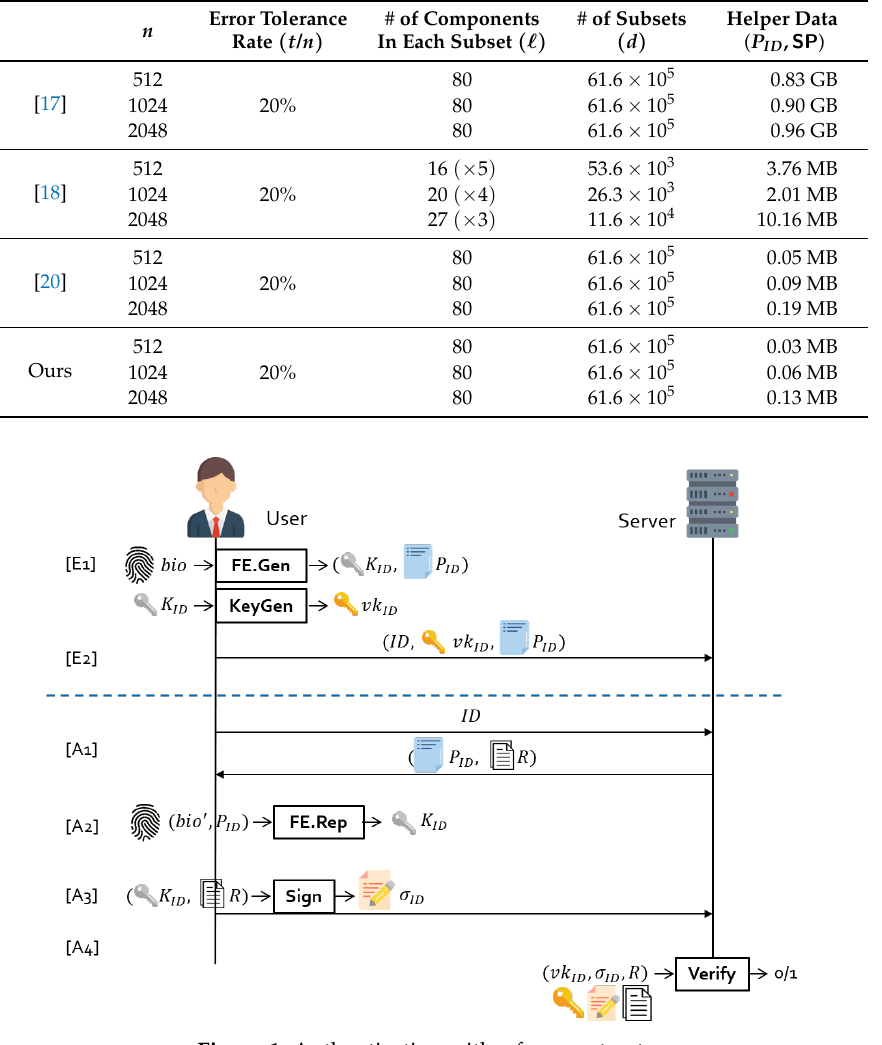
Table 2. Comparison of storage or transmission costs with helper data.